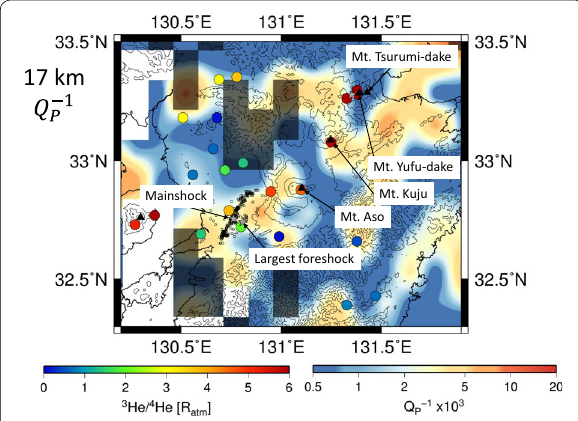
Fig. 4 Ratio of 3 He/ 4 He observed by Horiguchi and Matsuda (2013), which is plotted on the estimated Q P structure at 17 km depth shown in Fig. 2. Circles are color coded according to 3 He/ 4 He ratios in R atm . Gray stars indicate the largest foreshock, mainshock, and induced event. The small circles are the epicenters of the aftershocks. The black triangles denote the active volcanoes